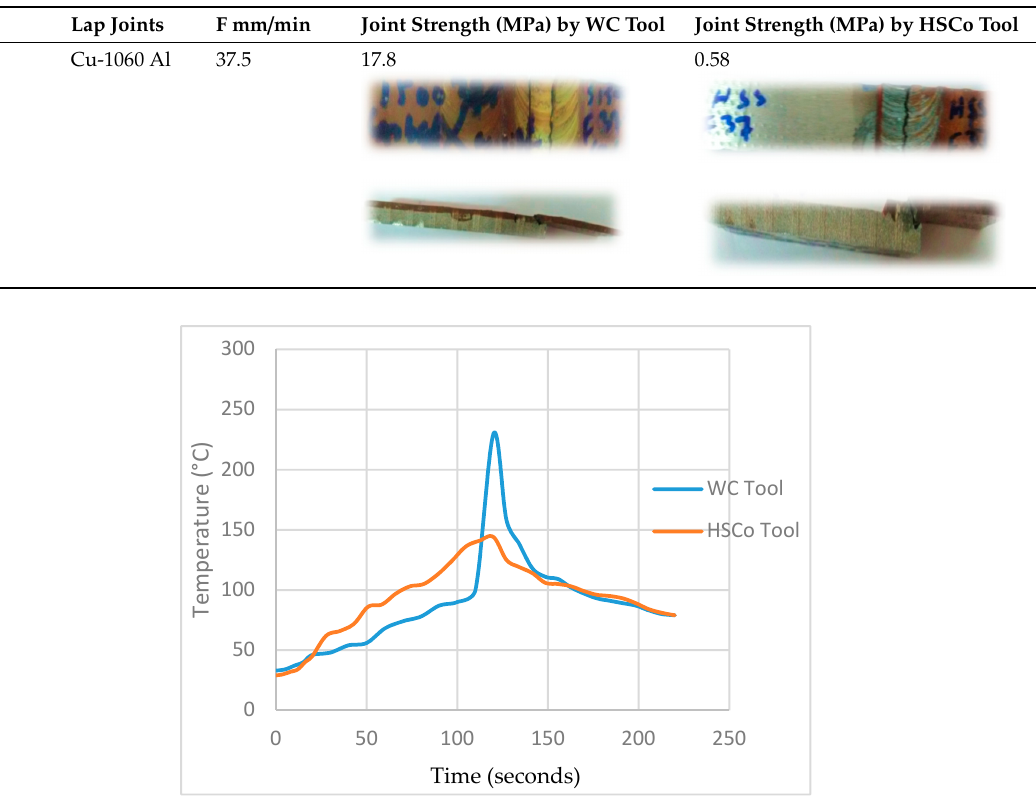
Figure 9. Effect of tool material on temperature profiles during FSW of 2219 Al-Cu joints with square-pin tools.